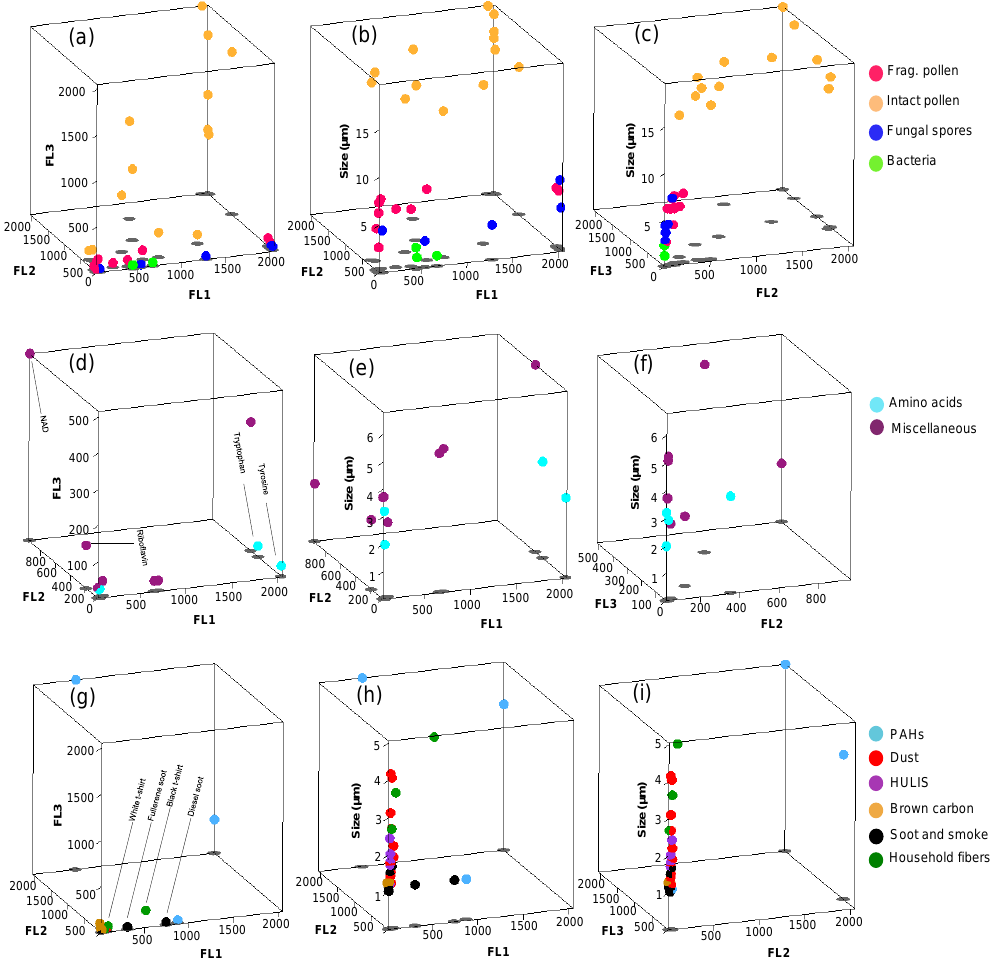
Figure 2. Representations including four of the five parameters recorded by the WIBS: FL1, FL2, FL3, and particle size. Biological material types (a–c) , bio-fluorophores (d–f) , and non-biological particle types (g–i) . Data points represent median values. Gray ovals are shadows (cast directly downward onto the bottom plane) included to help reader with 3-D representation. Tags in (g) and (d) used to differentiate particles of specific importance within